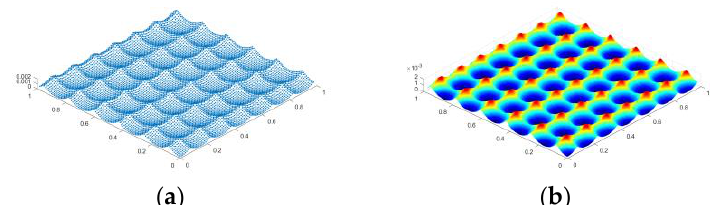
Figure 9. Topography simulation results of the machined surface. ( a ) Residual height z of the machined surface; ( b ) three-dimensional image of the machined surface.